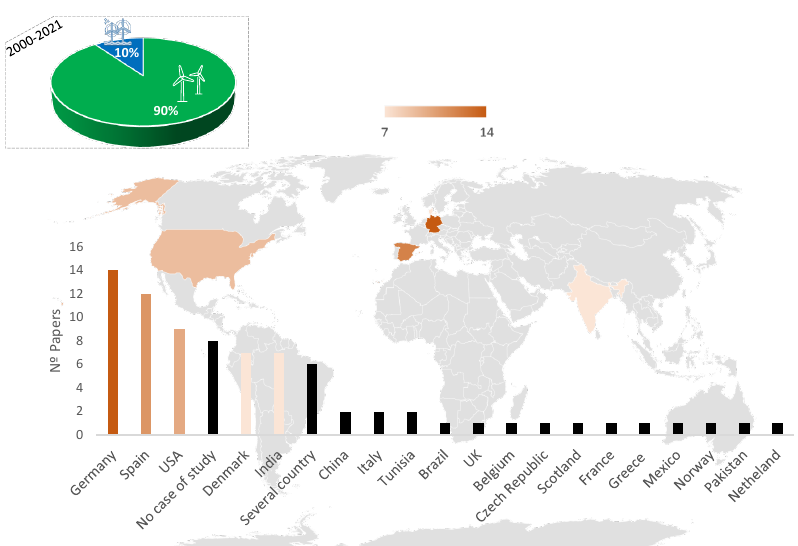
Figure 5. Scientific publications by country (2000–2021).